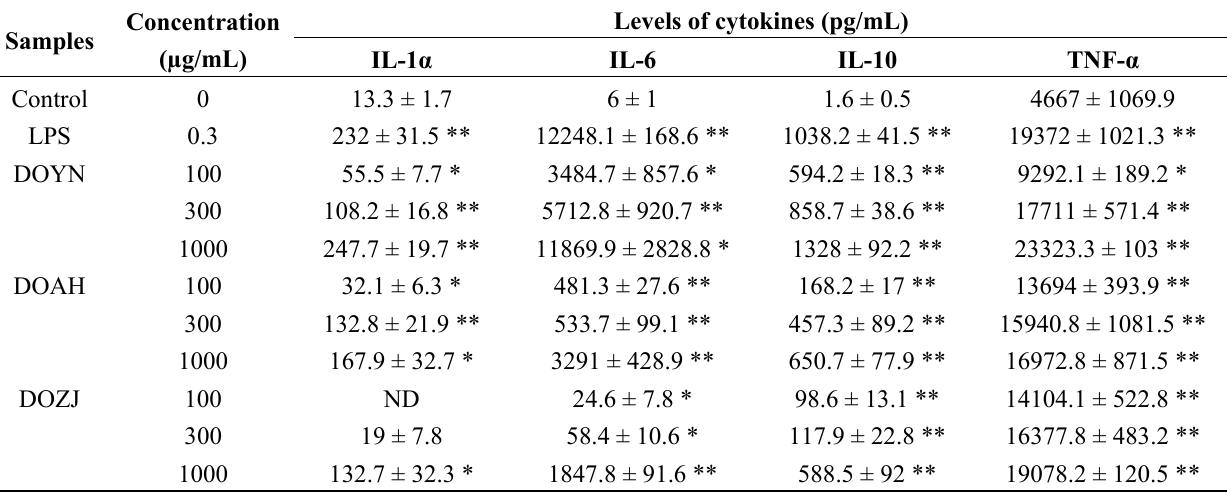
Table 4. Effects of crude polysaccharides from Dendrobium on the secretion of cytokines.